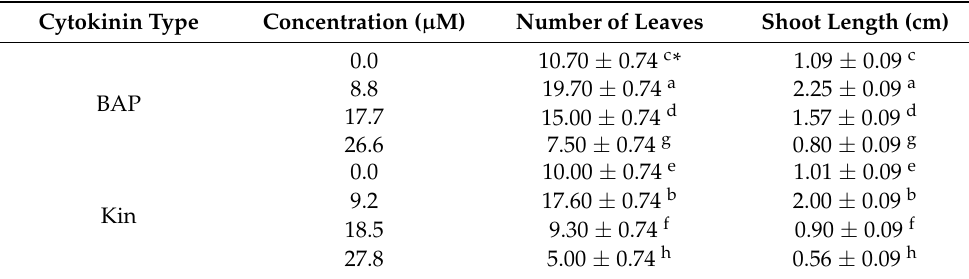
Table 2. Effect of different media types on microshoots growth after four weeks of incubating four-week-old microshoots (n = 10) regenerated from callus culture of C. montanus .